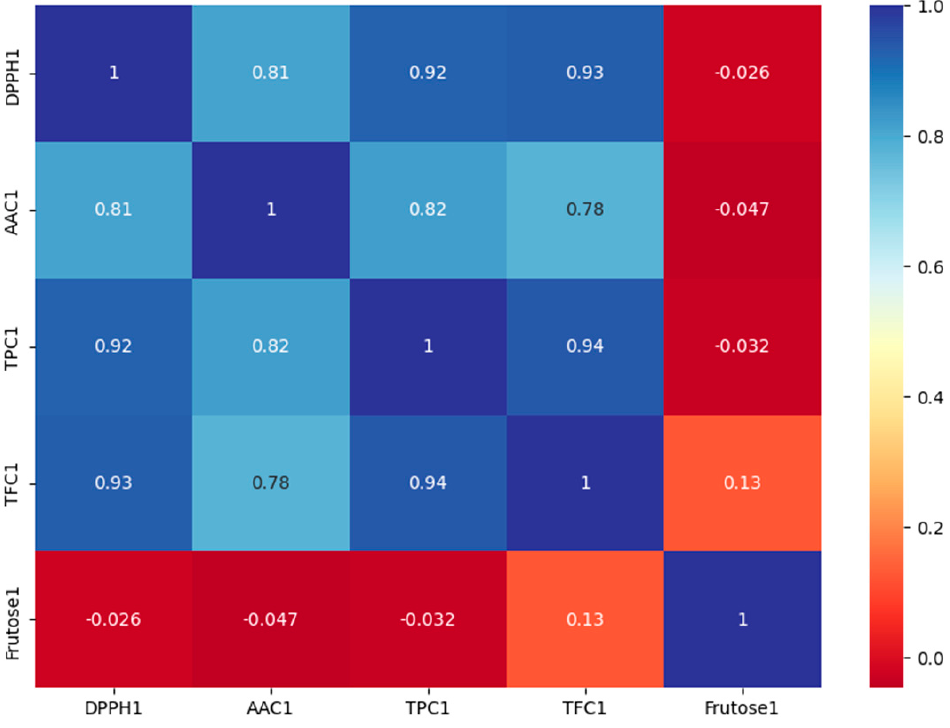
Figure 1. Correlation plot among the studied parameters.